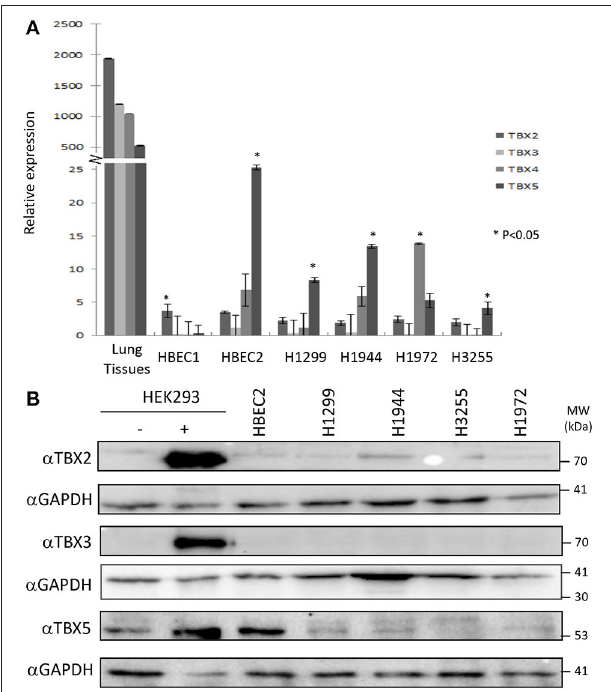
FIGURE 1 | mRNA/protein profiling of TBX2 subfamily members in normal lung tissues and lung cancer cell lines. The expression of TBX2, TBX3, TBX4, and TBX5 was analyzed by real-time PCR in the lung cancer cell lines NCI-H1299, H1944, H3255, and H1972 as well as the immortalized HBEC1/HBEC2 cells and normal lung tissues. A high expression of the four members was detected in lung tissues (A) as compared to the different cell lines while HBEC2 cells scored the highest expression for all the four genes among the cell lines. Gene expression was first normalized to the expression of the housekeeping gene GAPDH. The fold induction of each tested gene was then normalized to the expression in NHBE cells. The data represent the means ± s.d, ( n = 3). Significance was attributed as compared to the expression in lung tissues (* p < 0.05). The protein expression was assessed by western blotting of equal amounts of nuclear extracts from different lung cancer lines using specific antibodies for each protein (B) . Nuclear extracts from HEK293 cells overexpressing ( + ) or not (–) these proteins were used as